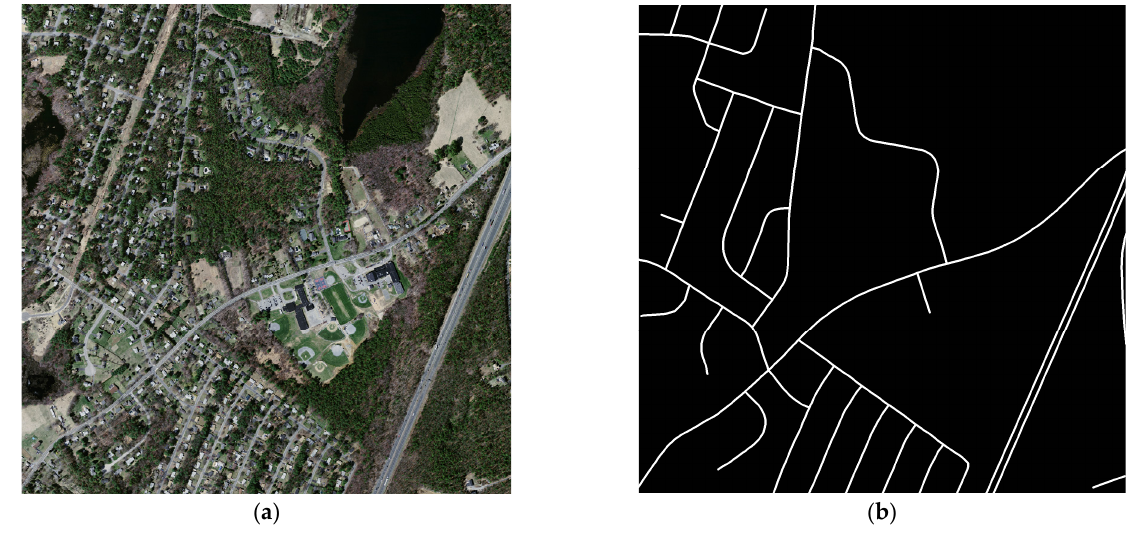
Figure 5. Massachusetts Road Dataset. ( a ) Image; ( b ) Label.